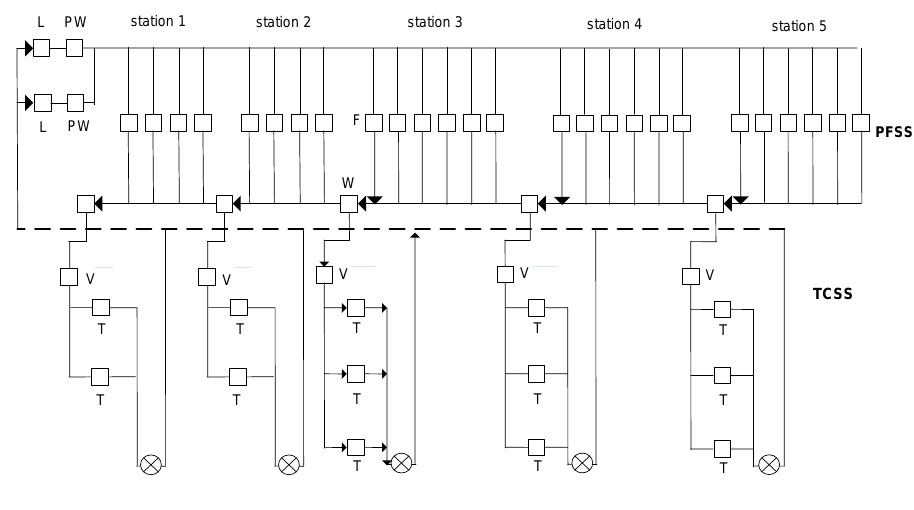
Figure 4. “Express lane layout (ELL)”. Source: Jeong and Hong